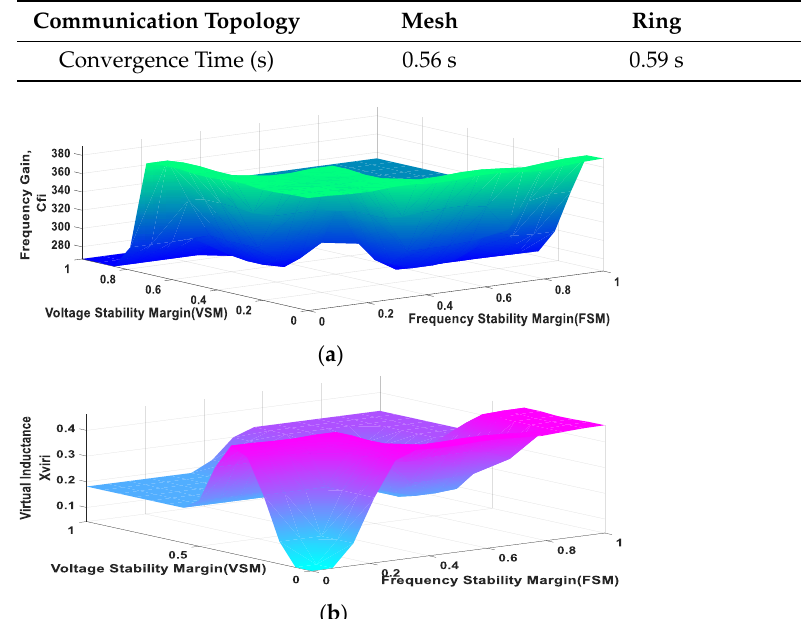
Table 3. Convergence time for various communication topologies.